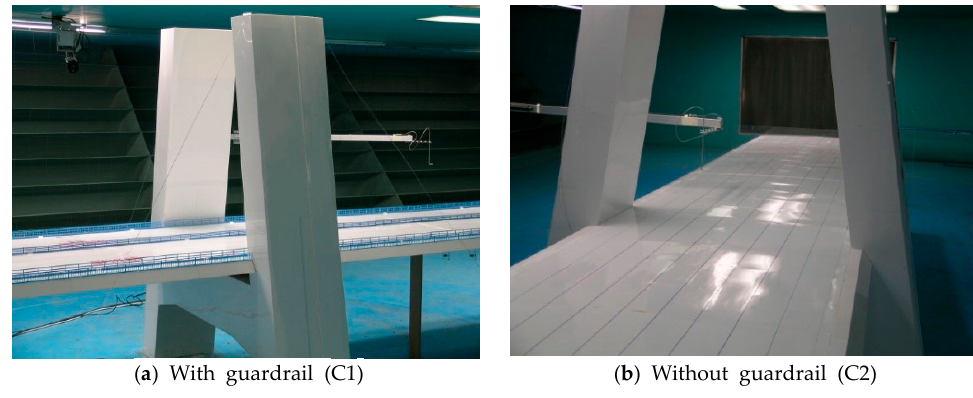
Figure 2. Segmental model.